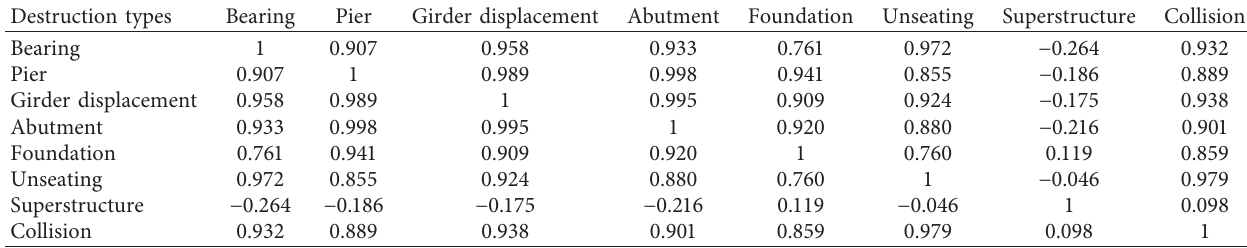
Table 1: Seismic damage correlation coefficient of bridge